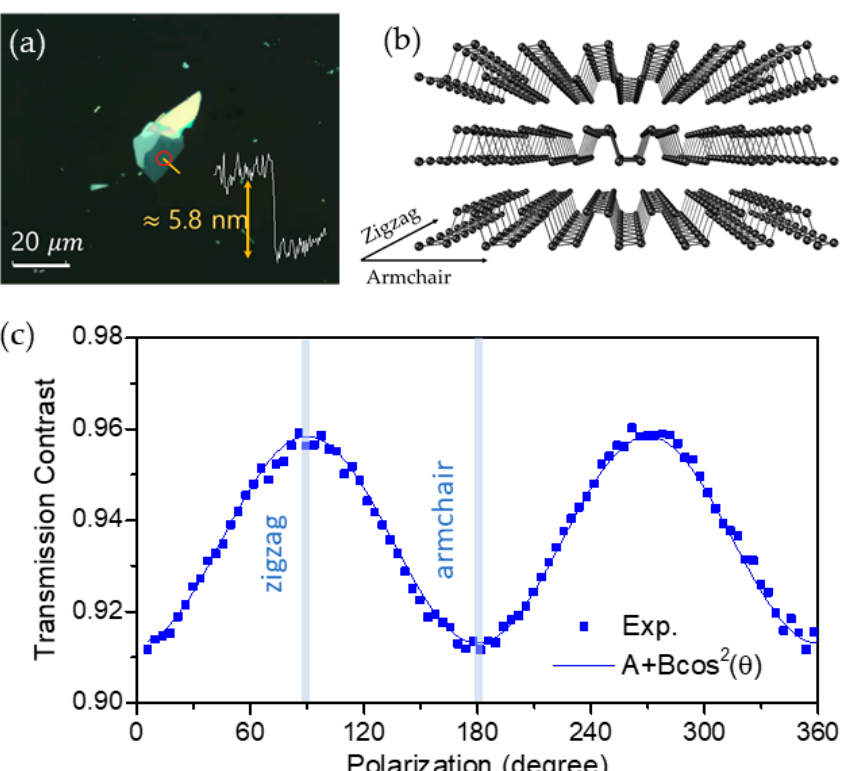
Figure 1. ( a ) Optical microscope image and AFM profile of the 5.8 nm thick BP flake. The area at which pump-probe measurements were performed is marked with a red circle. ( b ) Schematic diagram of the crystal structure of multilayer BP. ( c ) Polarization-resolved transmission showing the linear dichroism of BP. The solid line is a fitting with the A + B × cos 2 ( θ ) function.